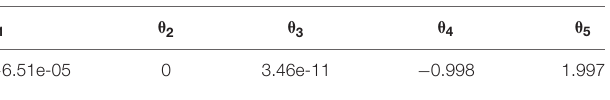
TABLE 1 | LR model